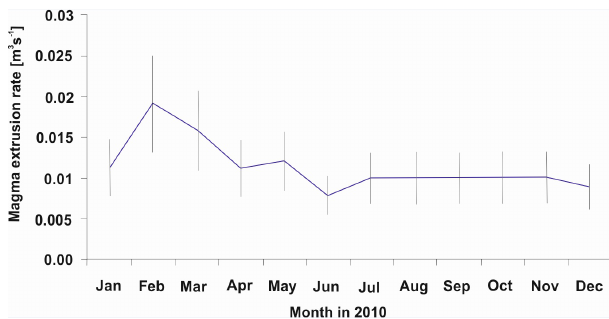
Fig. 11. Magma extrusion rate of Volc´an de Colima in 2010, with an error of 35%; calculated with the seismic amplitude – photographic method. The maximum was in February 2010 with 0.019m 3 s − 1 , the minimum was in June 2010 with 0.008m 3 s − 1 . The average extrusion rate in 2010 was 0.0113m 3 s − 1 . In November 2010 the decrease of activity started and finally stopped in June 2011.